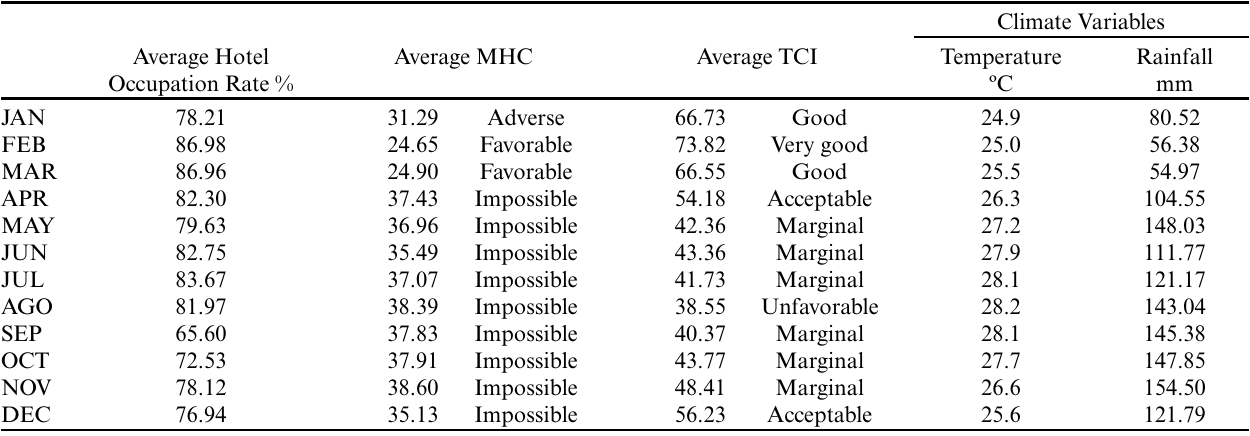
Table 4 . Average Hotel Occupation Rate (OCC), Average Mean Historical Climate for Tourism (MHC), and Average Tourism Climate Index (TCI) for the study